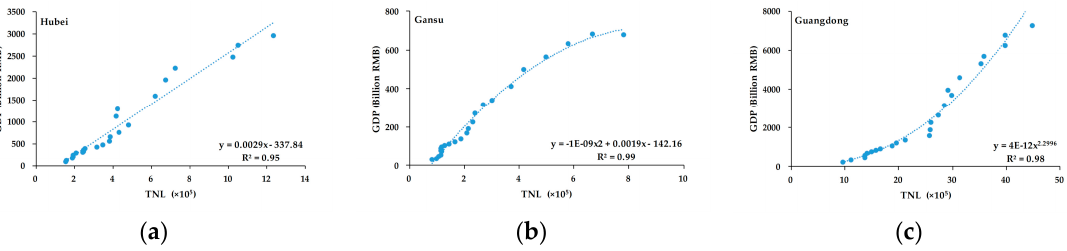
Figure 6. Optimal models of the relationship between the statistical GDP data and TNL for different provinces: ( a ) the linear model for Hubei; ( b ) the quadratic polynomial model for Gansu; ( c ) the power function model for Guangdong.